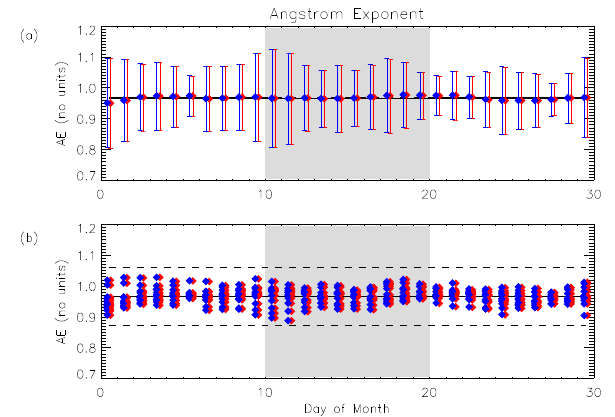
Fig. 7. ˚Angstr¨om exponent. In both parts of each plot, the solid hori- zontal line shows the mean of all 360 measurements. Blue diamonds represent unperturbed values, and red diamonds represent perturbed values. (a) The dashed horizontal lines show the uncertainty on the mean, as given in Eq. (7). The diamonds show the daily means, and the error bars show the 95% confidence interval of the distri- bution between the months on that day, as given in Eq. (6). The ensemble mean is always within the 95% CI for both perturbed and unperturbed runs. (b) The dashed horizontal lines show the 95% confidence internal of the ensemble, and the diamonds show each of the individual measurements on that day. The perturbed data are no more likely to fall outside this limit than the unperturbed data. Table 3. The number and percentage of grid boxes for which the F-test found that variance between different days of the month was statisticially significantly greater than the variance between differ- ent months. In the case of N 10 and CCN 70 , there is a small in- crease in the number of gridboxes which have a statisticially signif- icant F-statistic, but for AE 340 − 440 there is a small decrease. There are fewer grid boxes overall for AE 340 − 440 because it is a column- integrated quantity.